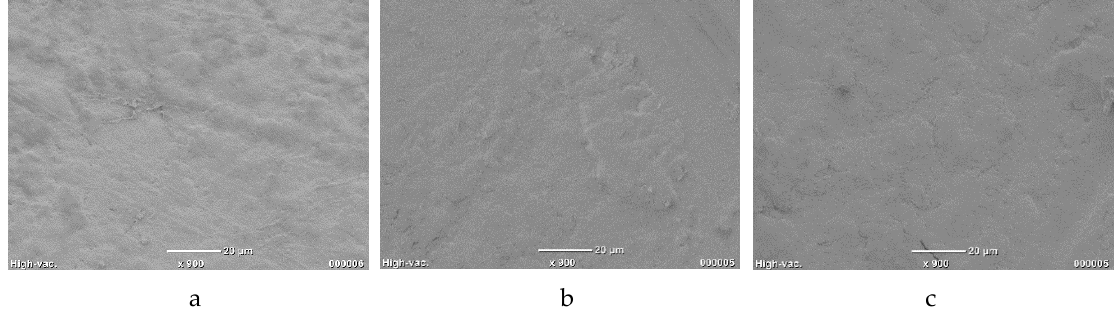
Figure 8. SEM micrographs of PLLA-GO/TiO 2 50 wt%: ( a ) before photocatalysis, ( b ) after the second run and ( c ) after the fourth photocatalytic run.